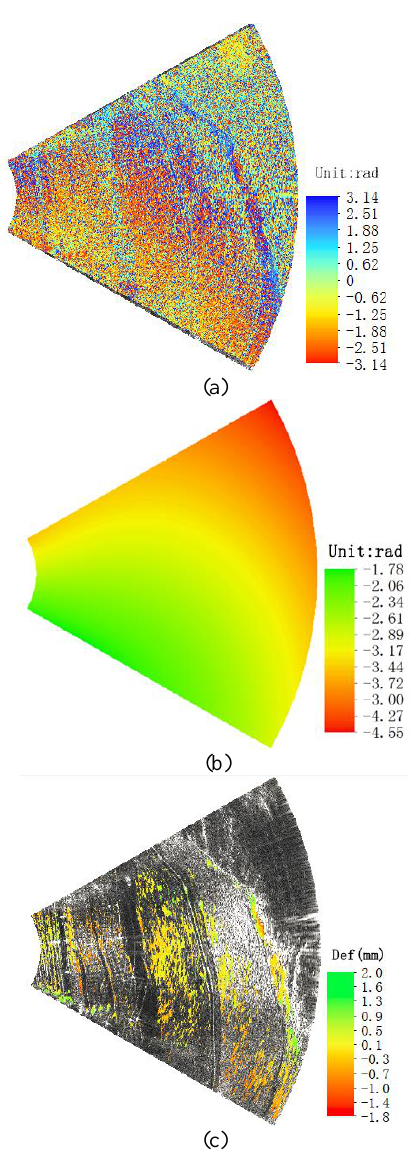
Figure 7. Experiment data. (a) Original Interferogram phase. (b) Corrected phase. (c)